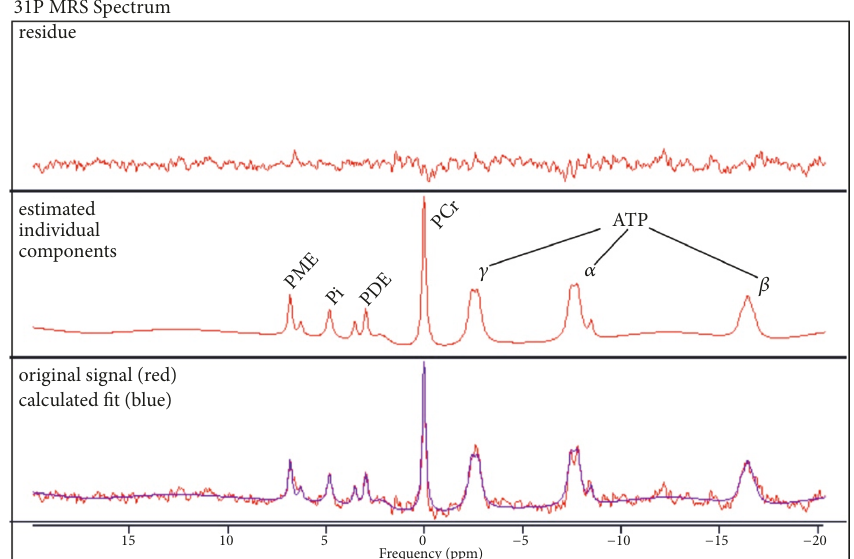
Figure 1: Examples for phosphorous magnetic resonance spectrum. The peaks of the different detectable membrane and energy metabolites from left to right: phosphomonoesters (PME), inorganic phosphate (Pi), phosphodiesters (PDE), and phosphocreatine (PCr), as well as three resonances of adenosine triphosphate (gamma-, alpha-, and beta-ATP). The vertical axis displays arbitrary units, while the x-axis shows the chemical shift difference to PCr in ppm. The original signal is depicted as the red curve and the calculated fit can be seen in blue.